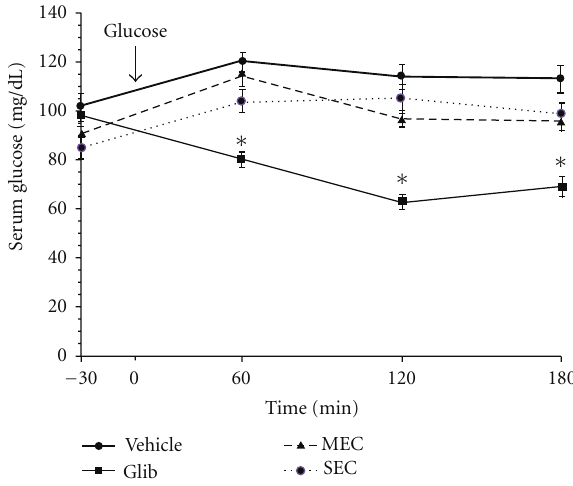
Figure 1: E ff ect of test compounds on glucose tolerance test (GTT) in normal rats. After 16h fasting, the animals were received water as vehicle, glibenclamide (1mg/kg), or test compounds (1g/kg) orally thirty minutes before administration of glucose (2g/kg). The data are expressed as mean ± SEM ( n = 8). ∗ P < 0 . 01 compared with the corresponding values at all other groups. Glib: glibenclamide-MEC: macerated extracts compound; SEC: Soxhlet extracts